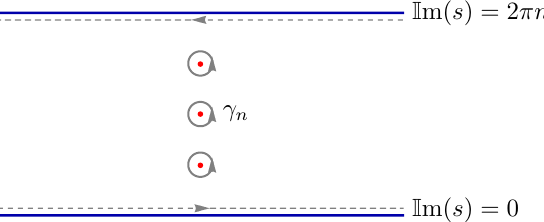
Figure 13 . Integration contour (depicted in solid gray) used to evaluate the complex integral in (A.7). Assuming that integrand vanishes for R e( s ) ! (cid:6)1 , we can then deform the contour (cid:13) n to just be the dashed gray lines at I m( s ) = (cid:14) and at I m( s ) = 2 (cid:25)n (cid:0) (cid:14) with (cid:14) > 0. For illustrative purposes, we have picked the value n = 4 to make this